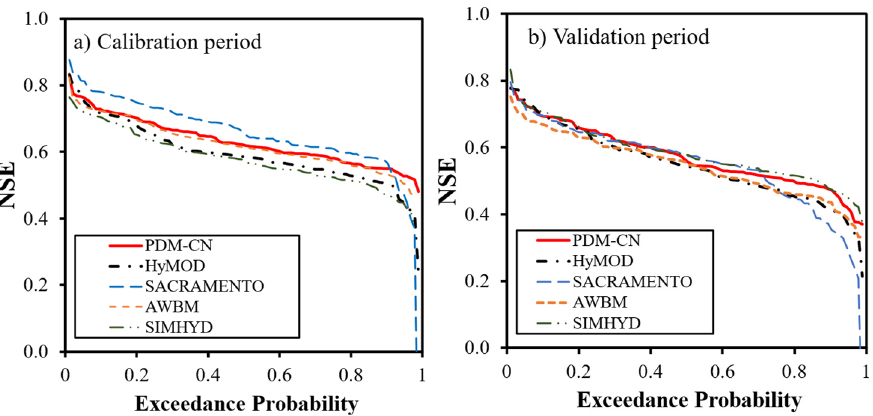
Figure 5. The exceedance probability of the number of catchments, with respect to NSE, during the calibration ( a ) and validation ( b ) periods.